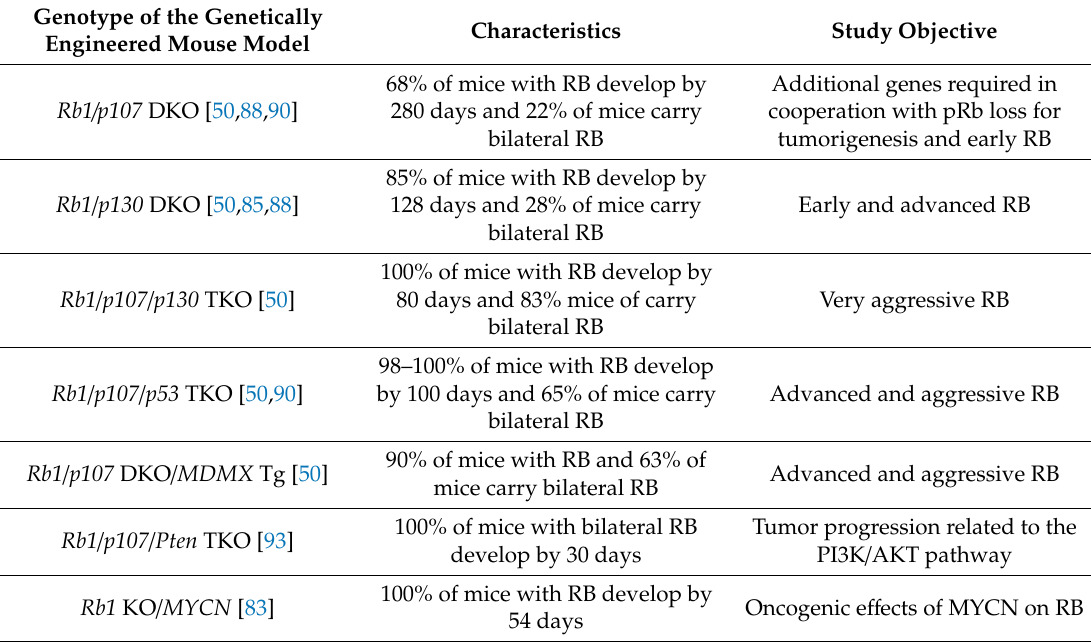
Table 3. Genetically engineered mouse models of retinoblastoma